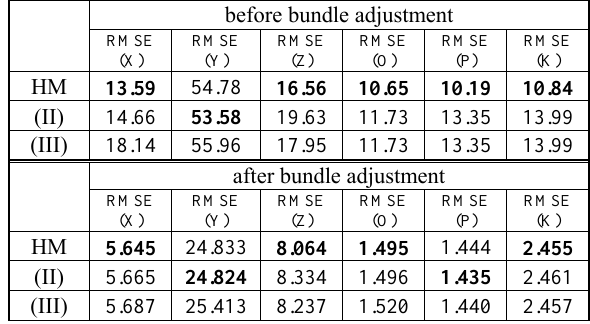
Table. 5 Relative accuracy assessment. Taking the exterior